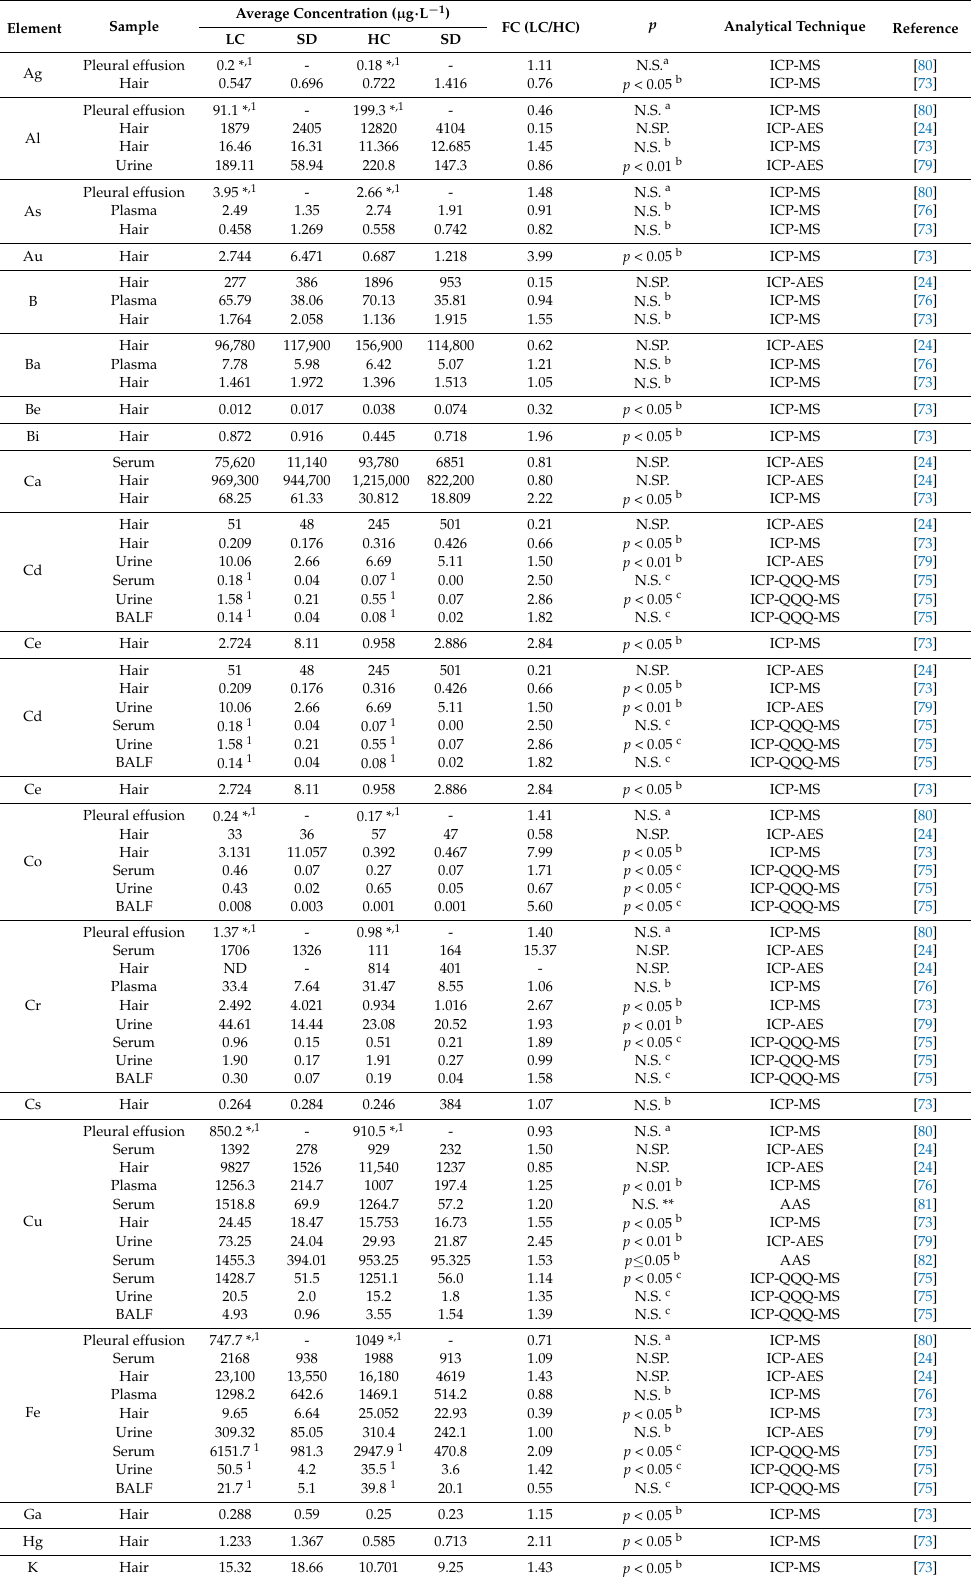
Table 1. Typical concentrations of metals in biofluids and tissues of lung cancer (LC) patients.